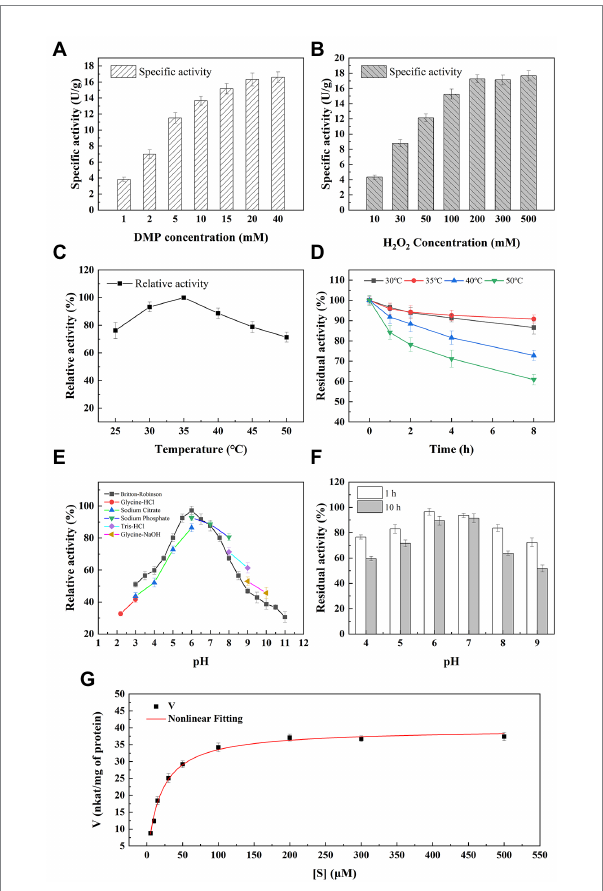
FIGURE 5 Enzymatic properties of M2822. Effect of 2,6-DMP (A) and H 2 O 2 (B) concentration on M2822 activity; Influence of temperature on the activity (C) and stability (D) of M2822; Influence of pH on the activity (E) and stability (F) of M2822; (G) Michaelis–Menten kinetics were performed at optimal